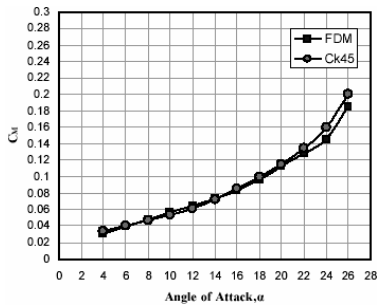
Fig. 8 Comparison of total axial force coefficient at Mach 0.9